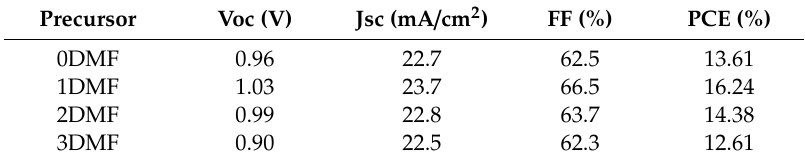
Table 1. Photovoltaic parameters of champion devices based on di ff erent precursor.